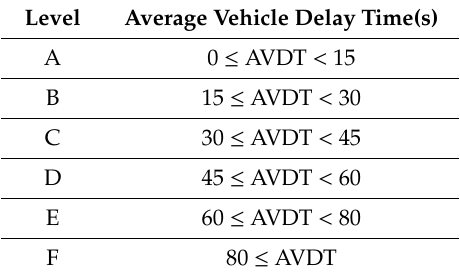
Table 1. Road tra ffi c congestion